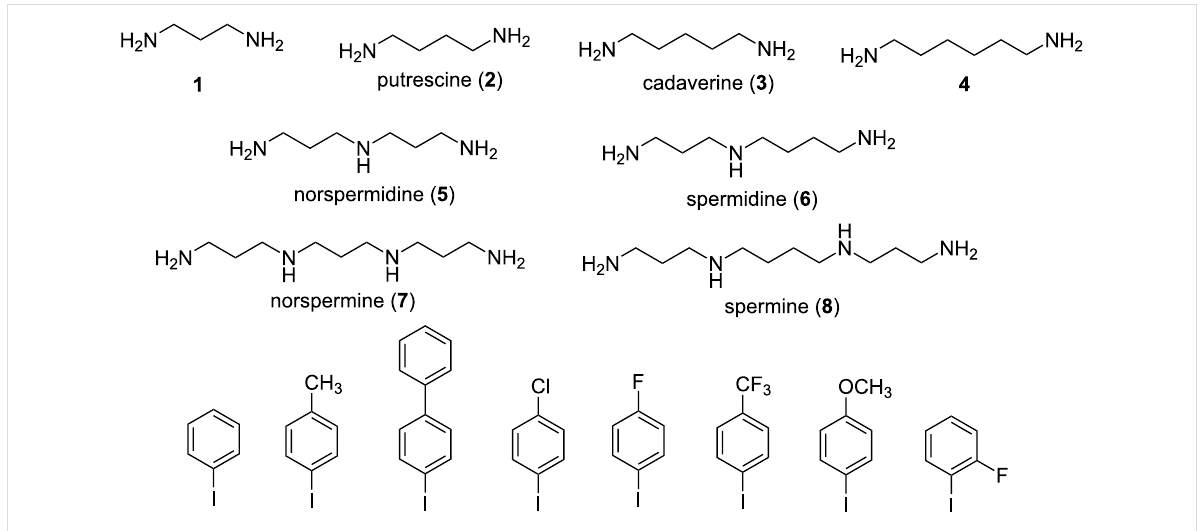
Figure 1: Diamines and polyamines studied in Cu(I)-catalyzed amination reactions.